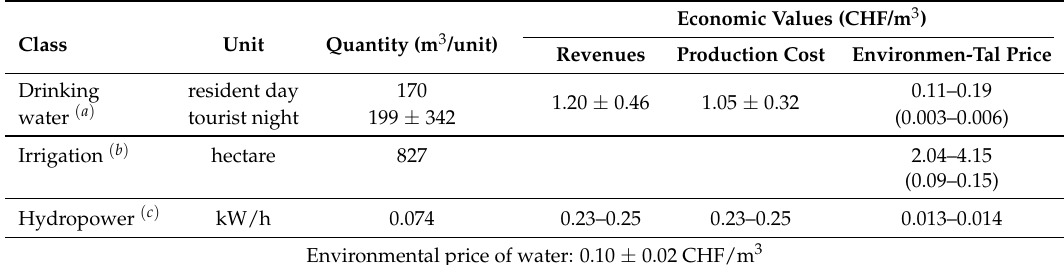
Table 3. Estimated water environmental prices for the Navisence